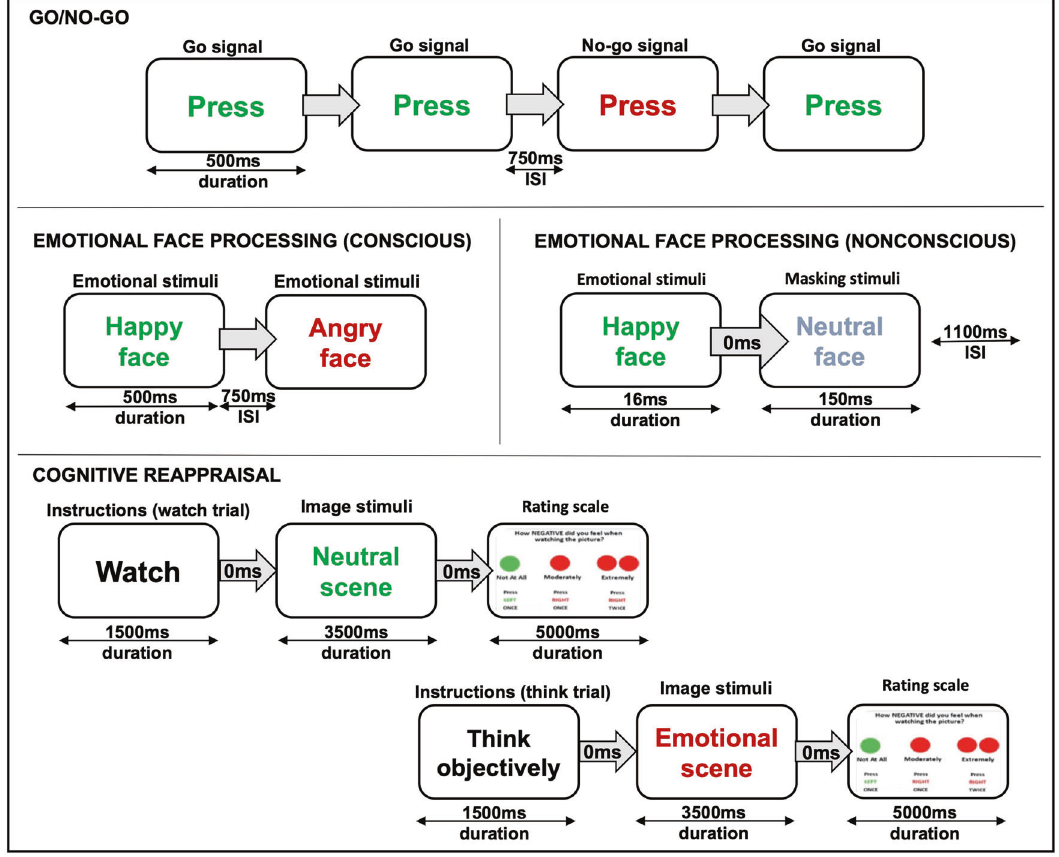
Fig. 1 Summary of tasks performed by participants. Each participant performed every task. There was a conscious and nonconscious version of the emotional faces